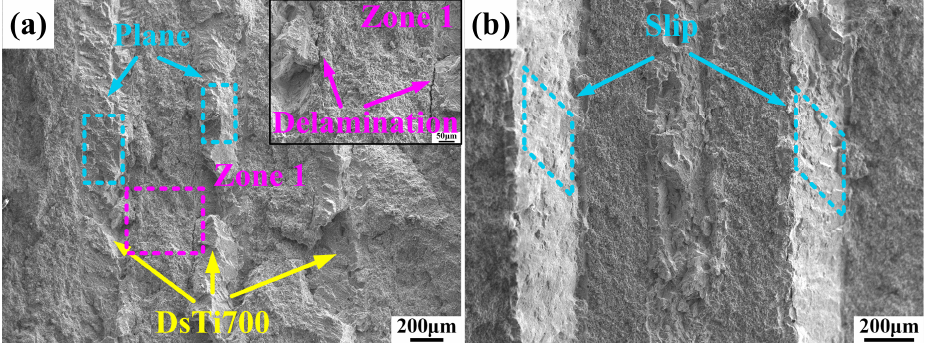
Figure 7. 25 °C macroscopic fracture morphology of the initial and heat-treated composites: ( a ) initial composite and ( b ) HT3.